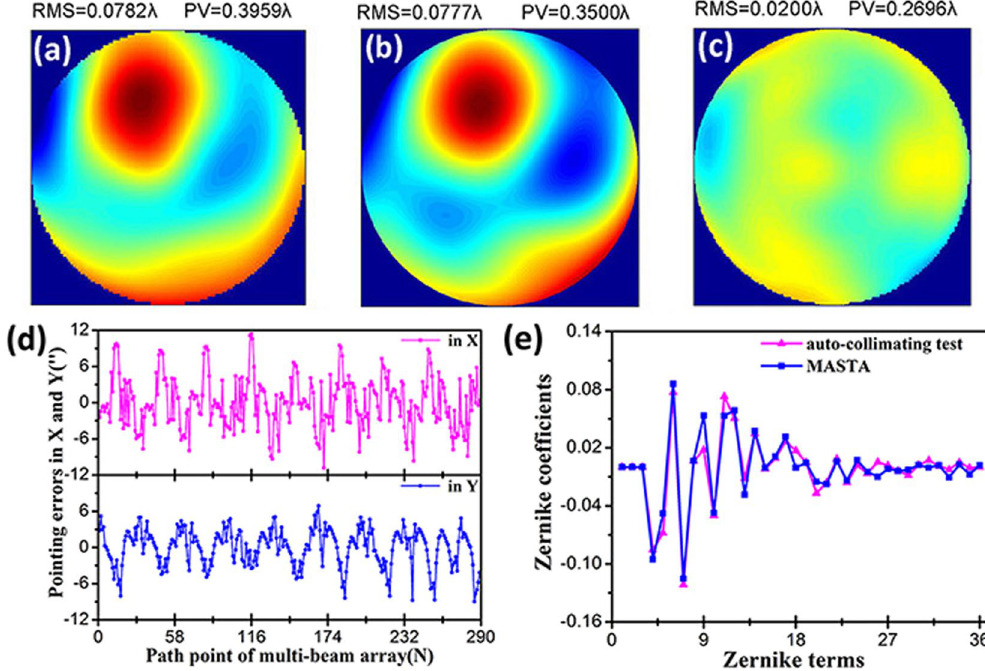
Figure 10. ( a ) WFE map measured with the MASTS, ( b ) WFE map of the first 37 Zernike modes measured by the auto-collimating test, ( c ) WFE difference between the auto-collimating test and the MASTS, ( d ) line and scatter graphs for pointing errors of the collimator array with changing path point, ( e ) coefficients of the Zernike terms for the auto-collimating test and the MASTS.